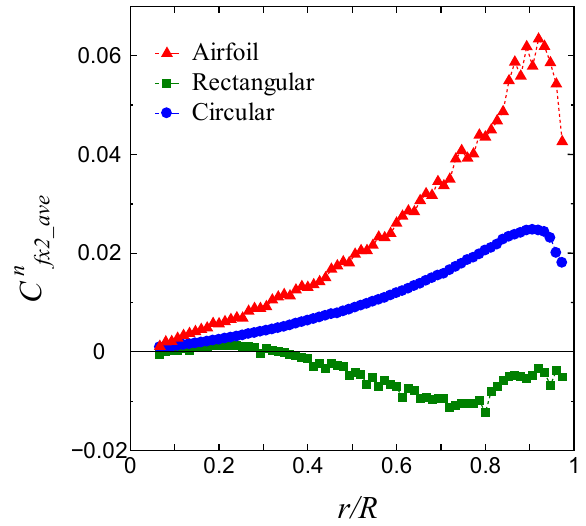
Figure 19. Distribution of the x 2 -direction friction-based force coefficients, or friction drag coefficient, on each arm. The data at the respective radial position were averaged over the seventh rotor-revolution using Equation (9).